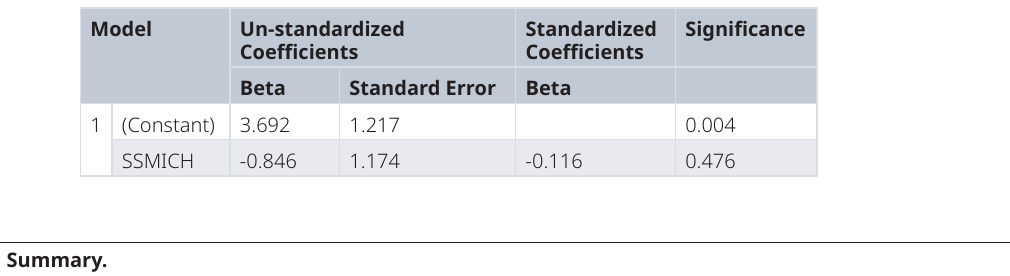
Table 2c. Coefficients.